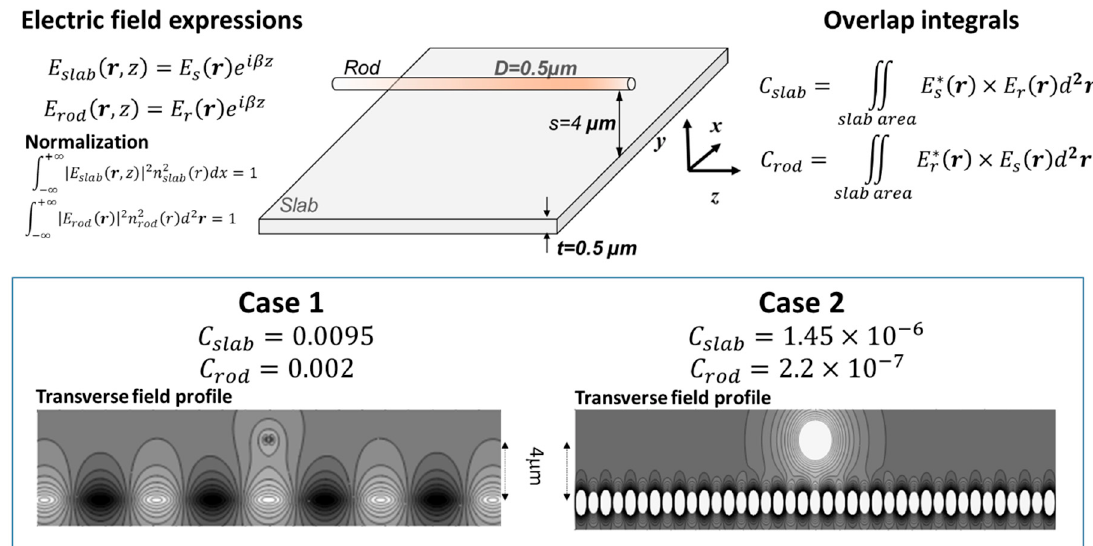
Figure 14. Top: Schematics of an optical coupling between a cylindrical dielectric rod and a semi-infinite dielectric slab. The rod has a diameter of 0.5 µm and a refractive index n rod = 1.45, the slab thickness is set to 0.5 µm, and the distance between the rod and the slab to 4 µm. The operating wavelength λ = 1.55 µm for two cases. Case 1: the slab index is n slab = 1.1. Case 2: n slab = 1.45. Bottom: Calculated electric transverse field profile and the overlap integrals for the two cases.